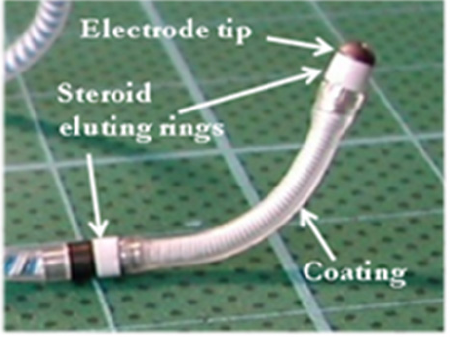
Figure 1: X-ray picture of an implanted pacemaker and electrodes [5].